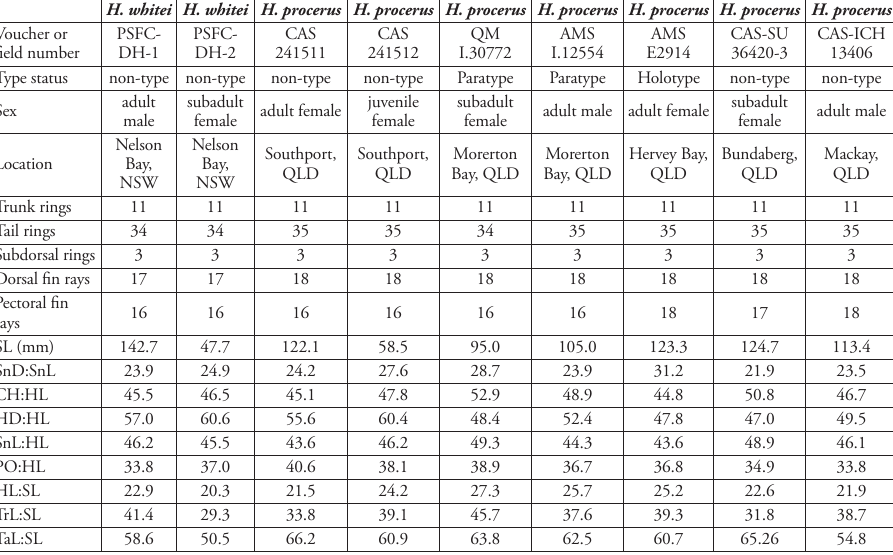
Table 2. Counts and morphometric measurements of specimens of H. whitei from Nelson Bay, NSW and those referred to as H. procerus from Southport, Moreton Bay, and Hervey Bay, QLD. Abbreviations: SnD (snout depth), SnL (snout length), CH (coronet height), HL (head length), HD (head depth), PO (post-orbital length), TrL (trunk length), TaL (tail length), SL (standard length). Numbers separated by a colon represent proportions (%). Lines present, from top to bottom, counts for trunk rings, tail rings, subdorsal rings, dorsal and pectoral fin